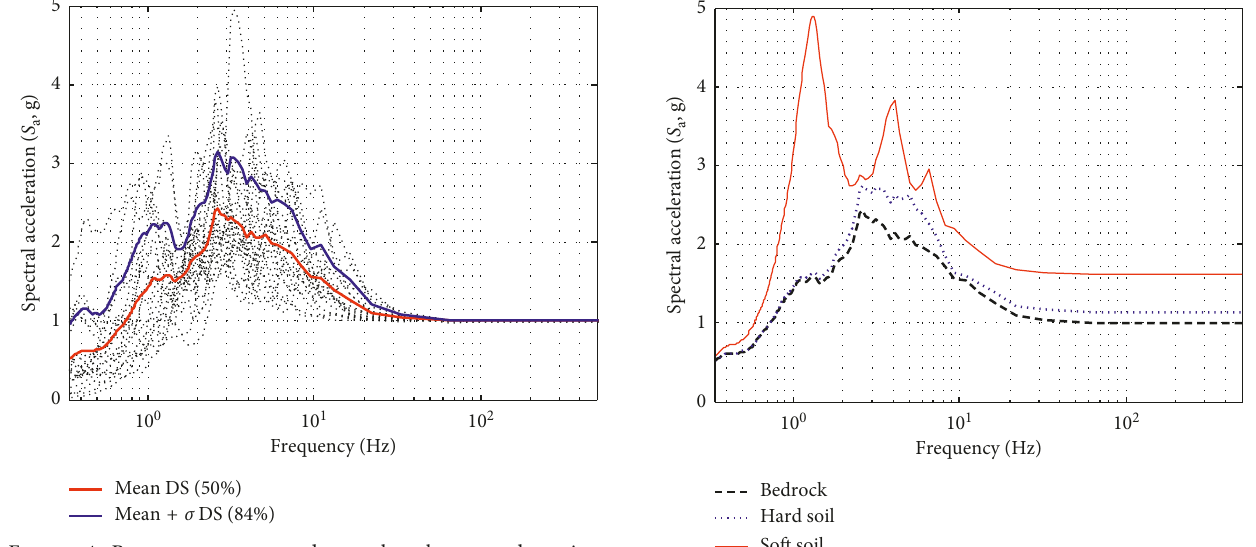
Figure 4: Response spectra under earthquake ground motions normalized to a PGA of 1.0g. Figure 5: Mean response spectra obtained from site response analyses in bedrock, hard soil, and soft soil